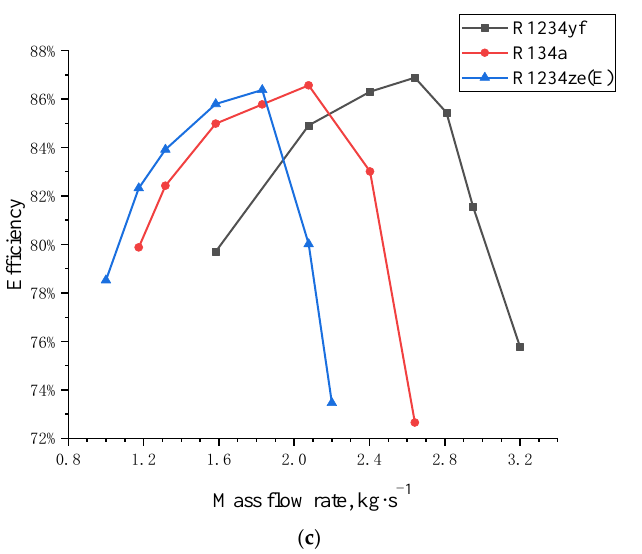
Figure 6. Performance curve of centrifugal compressor: ( a ) Mass flow rate-pressure ratio performance curve; ( b ) Mass flow rate-power performance curve; ( c ) Mass flow rate-efficiency performance curve.